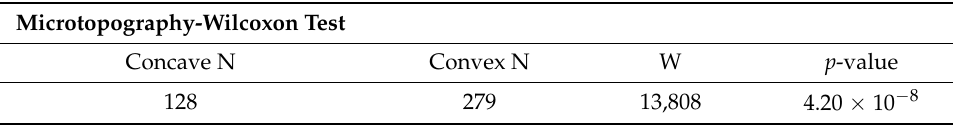
Table 6. The number of seedlings established in concave and convex plots.